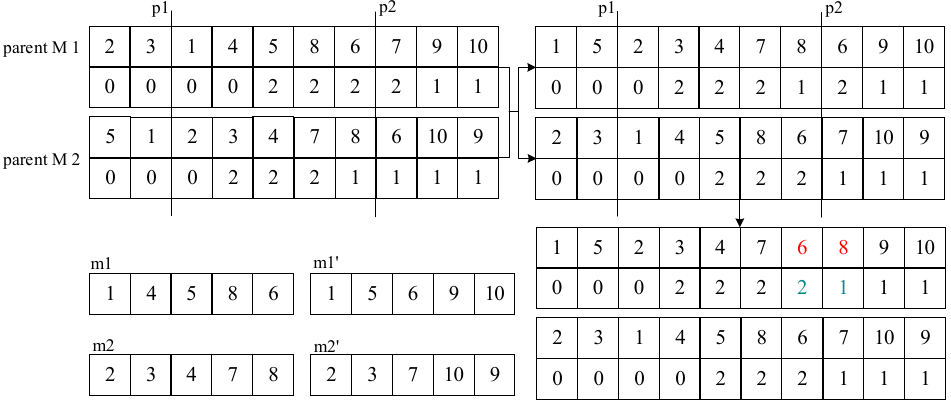
Figure 7. Chromosome crossover diagram.